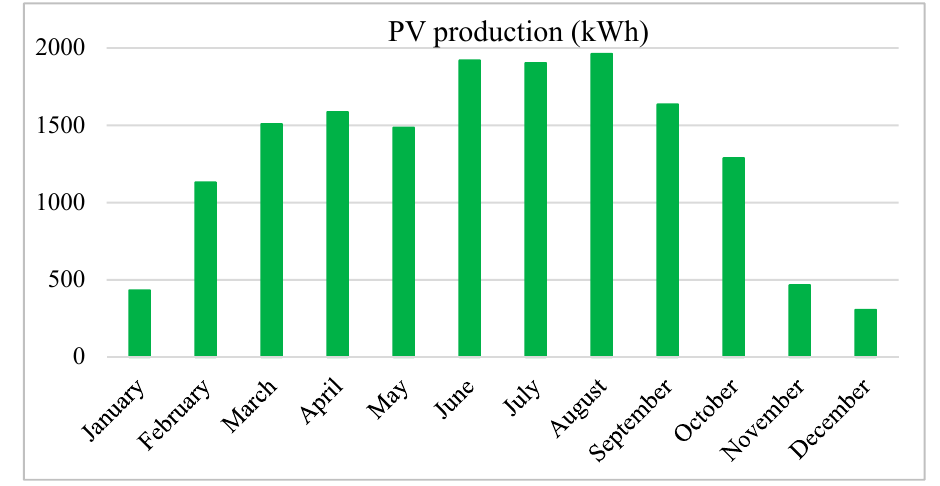
Figure 12. Total PV production per month in 2019 in kWh.